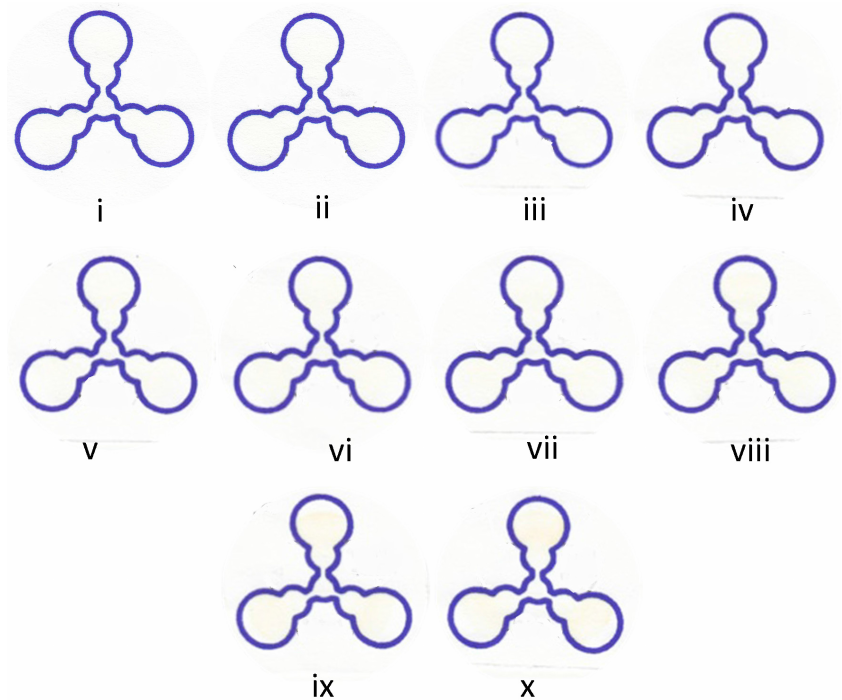
Figure 4. Digital photographic images of the glucose assay for the three-channel μPADs using a range ( i ) 0.0; ( ii ) 0.6; ( iii ) 1.9; ( iv ) 2.5; ( v ) 3.0; ( vi ) 3.3; ( vii ) 4.4; ( viii ) 6.25; ( ix ) 9.20; and ( x ) 12.1 mM of concentrations of glucose.